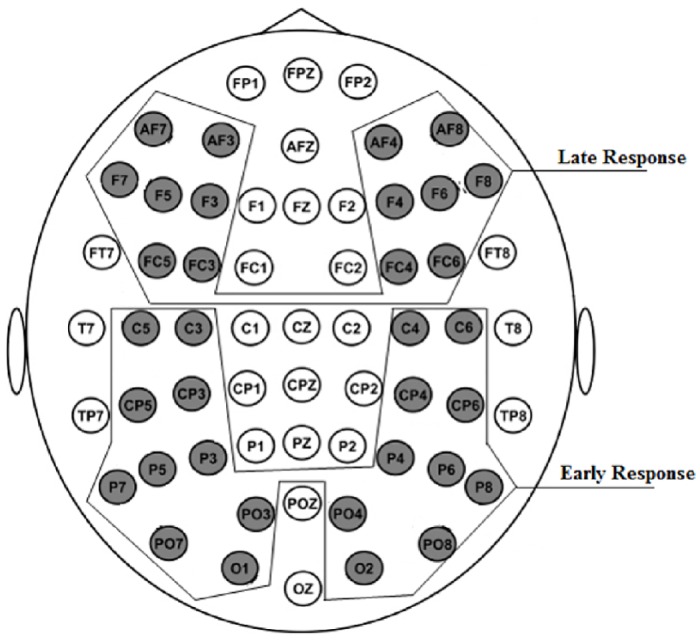
Electrode placement according to the 10—20 system, and pooling into early and late response signals.